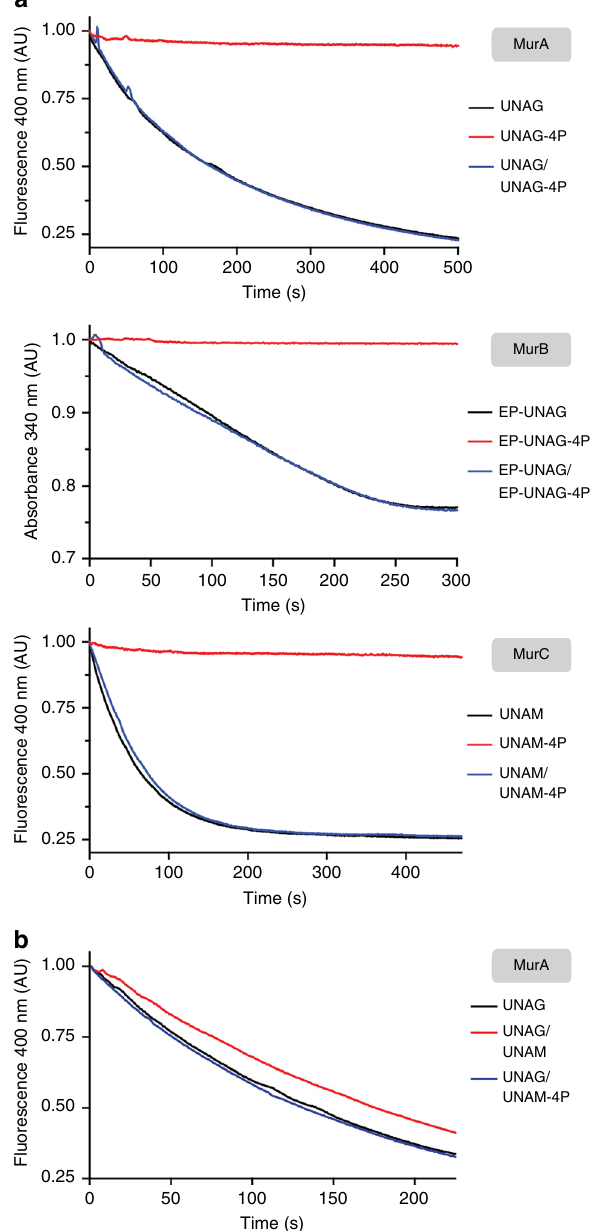
Fig. 4 Effect of ng ζ _1 products on enzymes involved in early peptidoglycan synthesis. a Effect of in vitro phosphorylated ng ζ _1 products on the activity of the fi rst three enzymes of the peptidoglycan synthesis, MurA (monitoring phosphate release), MurB (monitoring NADPH oxidation) and MurC (monitoring phosphate release). In vitro reactions were perfomed in presence of either the native non-phosphorylated substrate (black; 50 µ